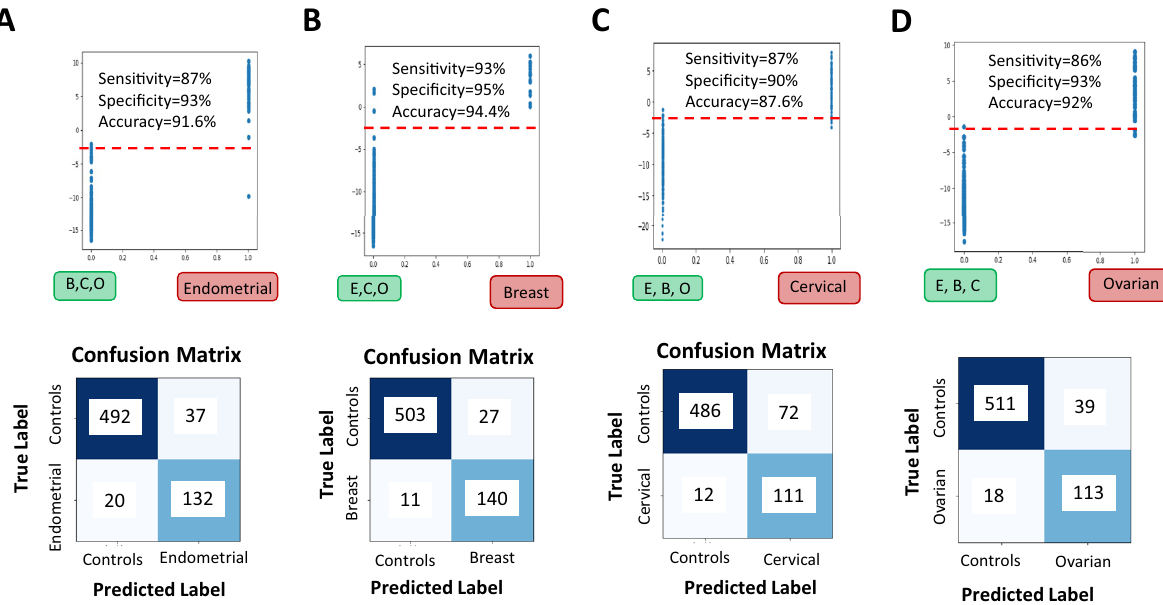
Figure 7. Testing the multiclass model for its ability to distinguish the individual cancer groups. Panel ( A ) shows the results of specifically testing the multiclass trained model for separation of endometrial cancer samples from the other cancers (breast, cervical, ovarian) based on model’s Endometrial scores. The resulting confusion matrix on applying a threshold shows good accuracy, sensitivity and specificity. Panel ( B ) shows the results of specifically testing the multiclass trained model for separation of breast cancer samples from the other cancers (endometrial, cervical, and ovarian) based on model’s Breast scores. The resulting confusion matrix on applying a threshold shows good accuracy, sensitivity and specificity. Panel ( C ) the results of specifically testing the multiclass trained model for separation of cervical cancer samples from the other cancers (breast, endometrial, ovarian) based on model’s Cervical scores. The resulting confusion matrix on applying a threshold shows good accuracy, sensitivity and specificity. Panel ( D ) shows the results of specifically testing the multiclass trained model for separation of ovarian cancer samples from the other cancers (breast, endometrial, cervical) based on model’s Ovarian scores. The resulting confusion matrix on applying a threshold shows high accuracy, sensitivity and